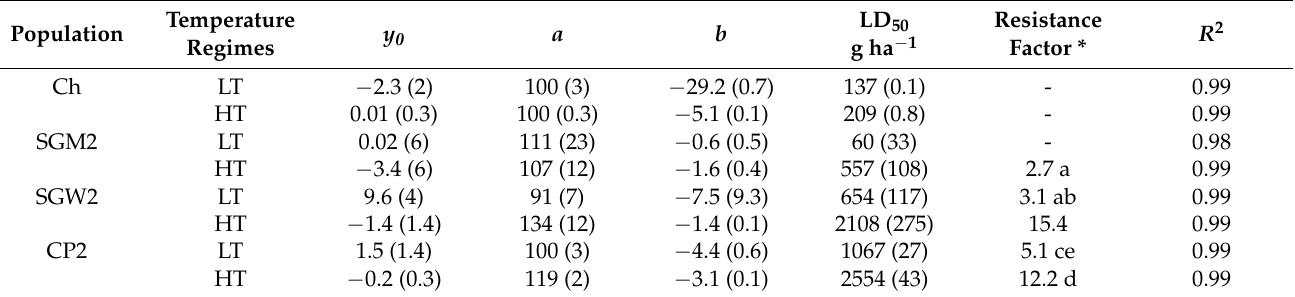
Table 2. Estimates of regression parameters and doses required for 50% mortality (LD 50 ) of Chloris virgata populations in dose–response studies conducted at high (35/25 °C) and low-temperature (25/15 °C) regimes in a glasshouse.